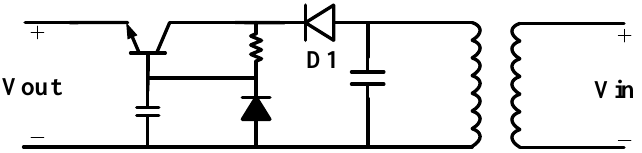
Figure 9. Architecture of the wireless power rectifier. A Schottky diode, D 1 , is